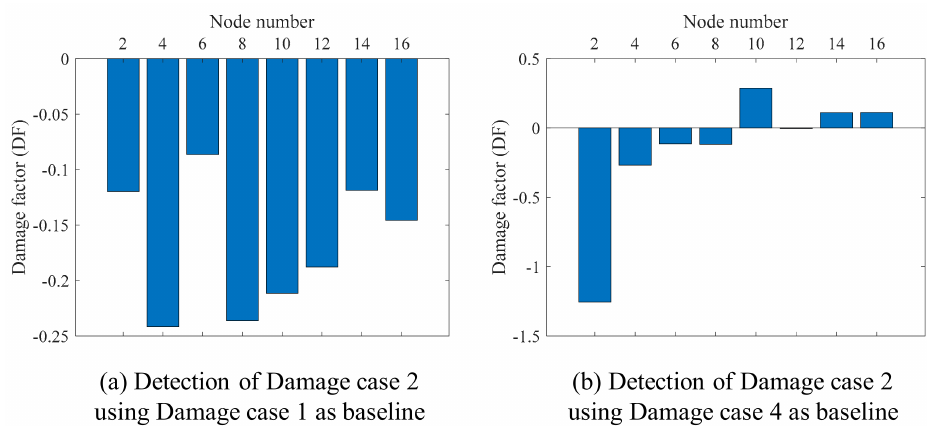
Figure 12. Damage detection using the relative changes between the different damage